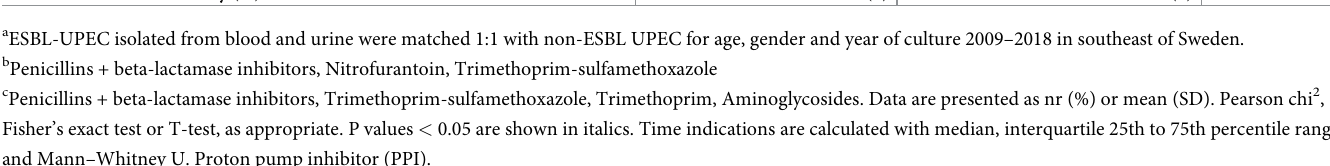
bla CMY-2 . No carbapenemase genes were detected. The distribution of ESBL-genes is shown in Fig 3 . Antibiotic therapy and outcome of patients with ESBL-UPEC versus non- ESBL-UPEC BSI Median times to empirical antibiotic therapy were similar between patients with ESBL-UPEC BSI and those with non-ESBL UPEC BSI (02:29 h vs. 02:07 h, respectively; p = 0.858). As shown in Table 1 , third-generation cephalosporins were the most commonly used antibiotics in patients with BSI caused by UPEC in both the ESBL and non-ESBL group (66% vs. 68%; p = 0.864). Patients with ESBL-UPEC BSI were less frequently treated with microbiologically appropriate empirical antibiotic therapy compared to patients with non-ESBL UPEC BSI (29% vs. 99% adequacy, respectively; p = < 0.001). Time to microbiologically appropriate antibiotic therapy differed significantly between ESBL-UPEC and non-ESBL UPEC BSIs (27:15 h vs. 02:14 h; p = < 0.001). Furthermore, the median length of hospital stay (LOS) for ESBL-UPEC BSI was 9 days compared to 5 days (p = < 0.001) for non-ESBL UPEC BSI ( Table 1 ). Almost 3% died within 30 days in this study. Table 1 shows that there was no significant difference in mortality rate between ESBL-UPEC (2 of 77) and non-ESBL UPEC (2 of 77) BSIs, nor regarding the development of urosepsis within 36 h (51% vs. 62%; p = 0.623). Risk factors associated with the development of ESBL-UPEC BSI Univariate analysis comparing ESBL-UPEC and non-ESBL UPEC BSIs was used to determine risk factors for ESBL-UPEC BSI. There were several significant risk factors: antibiotic treat- ment during the past 12 months (66% vs 36%); use of 3 rd generation cephalosporins within 12 months (23% vs 9%); UTI within the previous 12 months (49% vs 22%); recurrent UTI (44% vs 12%); genitourinary tumour (27% vs 8%); genitourinary invasive procedure within the pre- vious 12 months (39% vs 8%); previous findings of ESBL-producing E . coli (26% vs 1%); and previous urinary catheterisation (26% vs 9%). (Table 1)